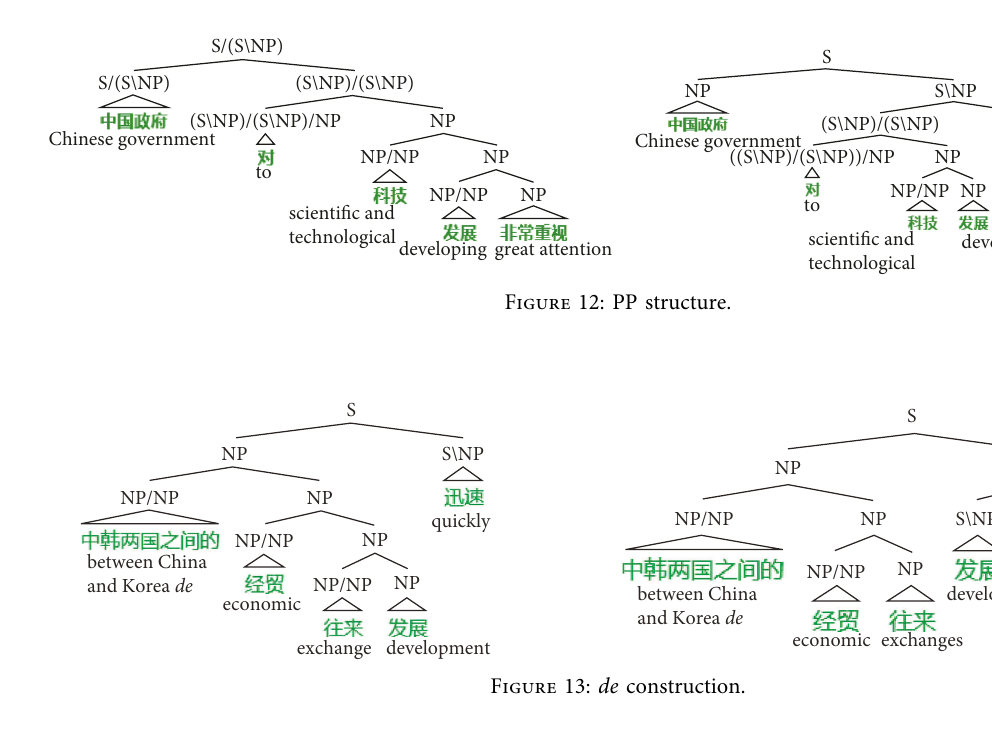
Figure 12: PP structure.